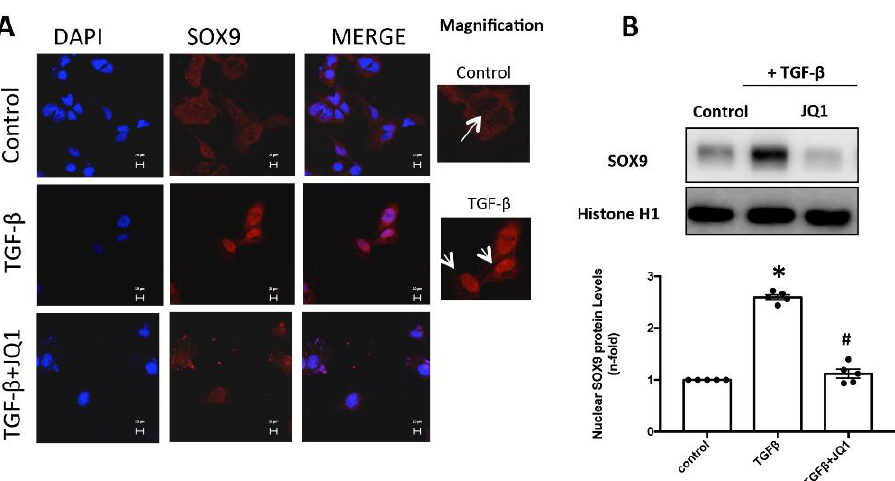
Figure 6. JQ1 blocked the nuclear translocation of SOX9 in human mesangial cells. Cells were pretreated with 5 uM JQ1 for 1 h and then stimulated with 10 ng/mL TGF- β 1 for 24 h. The nuclear localization of SOX9 was evaluated by immunofluorescence using a secondary Alexa 688 antibody ( A ) and Western blot ( B ). Data are expressed as mean ± SEM of 3 independent experiments and scale bar represents 20 µ M. * p < 0.05 vs. control # p < 0.05 vs. treated cells with TGF- β 1. Arrows indicate the presence or absence of SOX9 nuclear translocation.